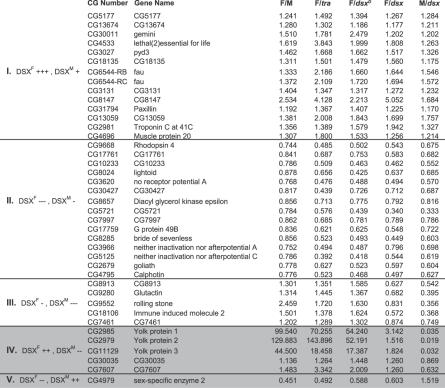
DSX Modes of RegulationThe 40 genes listed here showed significant differential expression in wild-type female versus male, female versus tra pseudomale, female versus dsxD pseudomale, female versus dsx null XX, and male versus dsx null XY in 0–24-h adult heads. Columns contain FC ratio values from the microarray data: F/M, female over male; F/tra, female over tra; F/dsxD, female over dsxD; F/dsx, female over dsx null XX; M/dsx, male over dsx null XY. The white region contains genes (34) that showed activation or repression by both DSXF and DSXM in the same direction, in both sexes. The gray region contains genes (six) that showed DSXF and DSXM acting in opposite directions. (I.) Activation by both DSXF and DSXM with higher level of activation by DSXF. (II.) Repression by both DSXF and DSXM with higher level of repression by DSXF. (III.) Repression by both DSXF and DSXM with higher level of repression by DSXM. (IV.) Activation by DSXF and repression by DSXM. (V.) Repression by DSXF and activation by DSXM. The symbols (+/−) in the first column are qualitative representations of activation (+) or repression (−), based on the microarray data.doi:0.1371/journal.pgen.0030216.g003